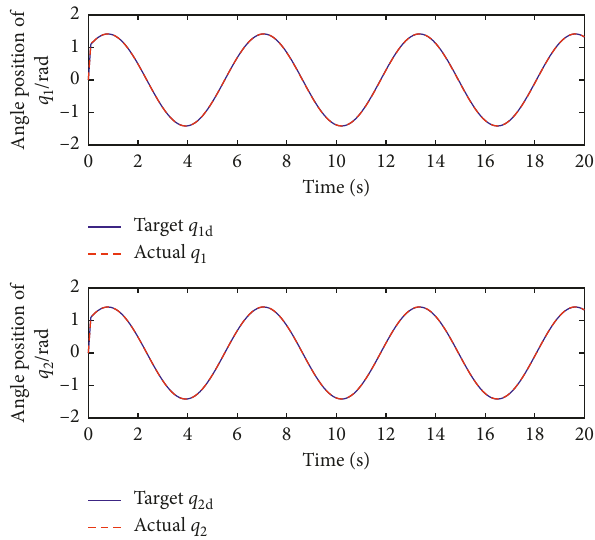
Figure 8: Tracking performance of q based controller with jumping parameters.